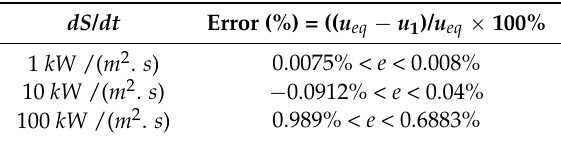
Table 1. Error presented at different irradiance